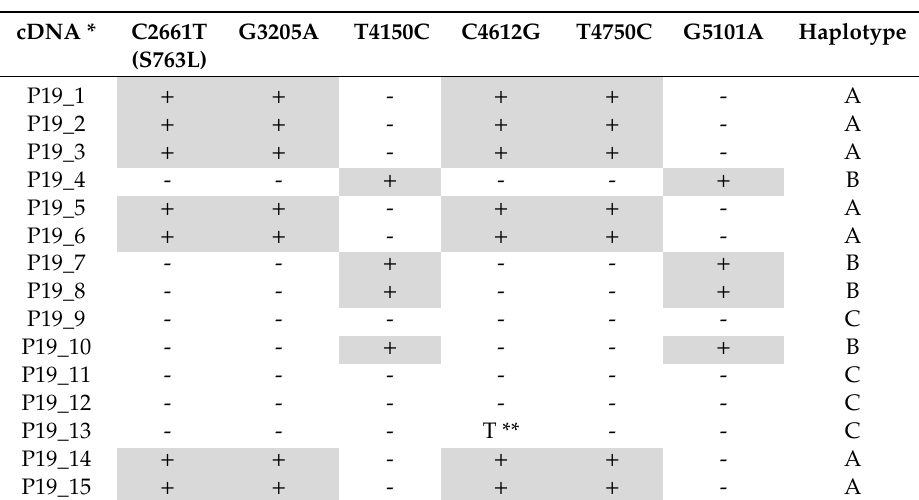
Table 2. Identification of virus